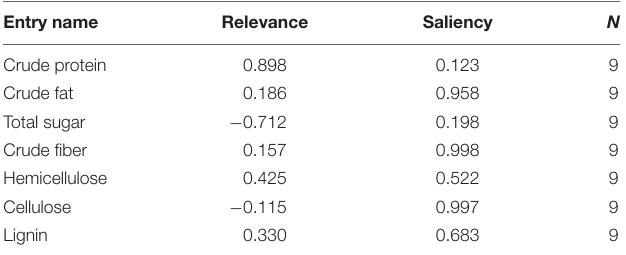
TABLE 5 | Correlation analysis of biomass components and alkalinity in fermentation